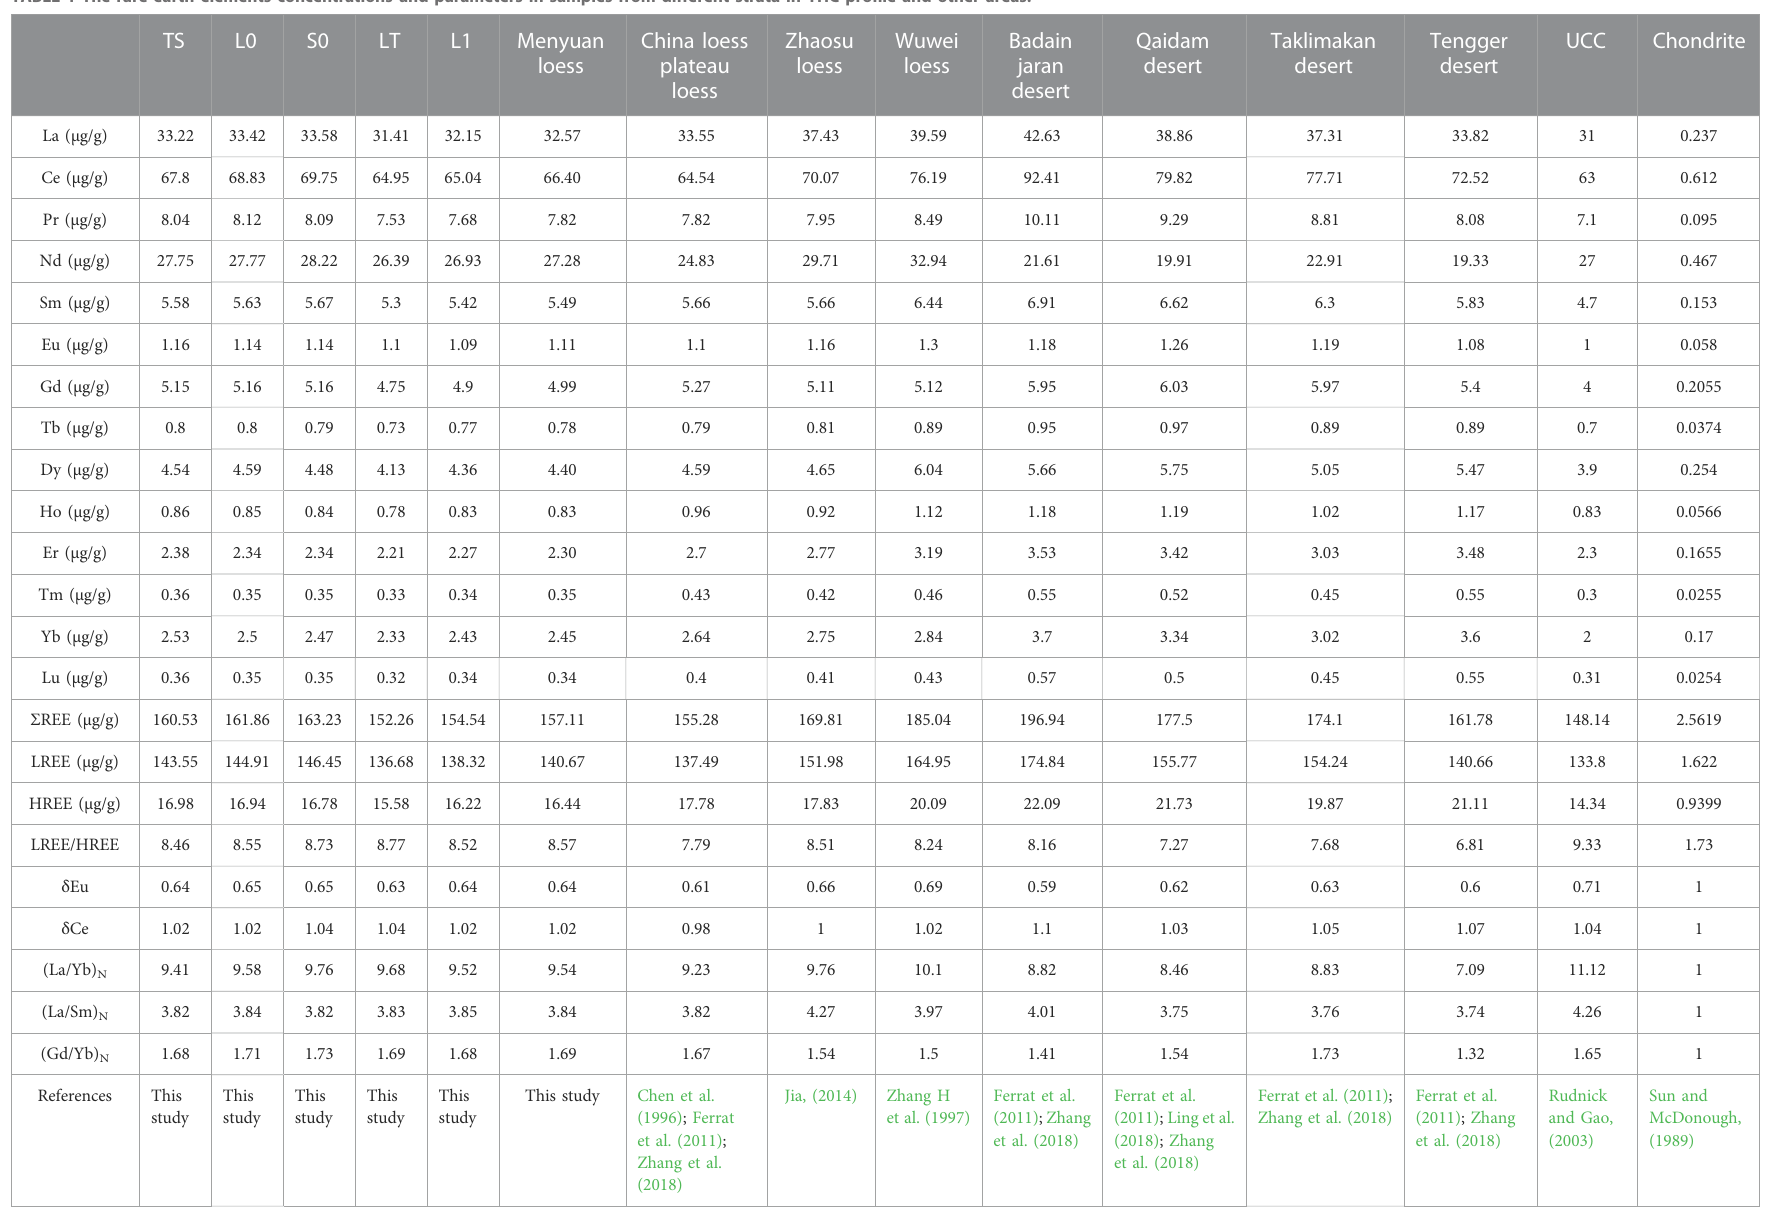
TABLE 1 The rare earth elements concentrations and parameters in samples from different strata in YHC pro fi le and other areas.